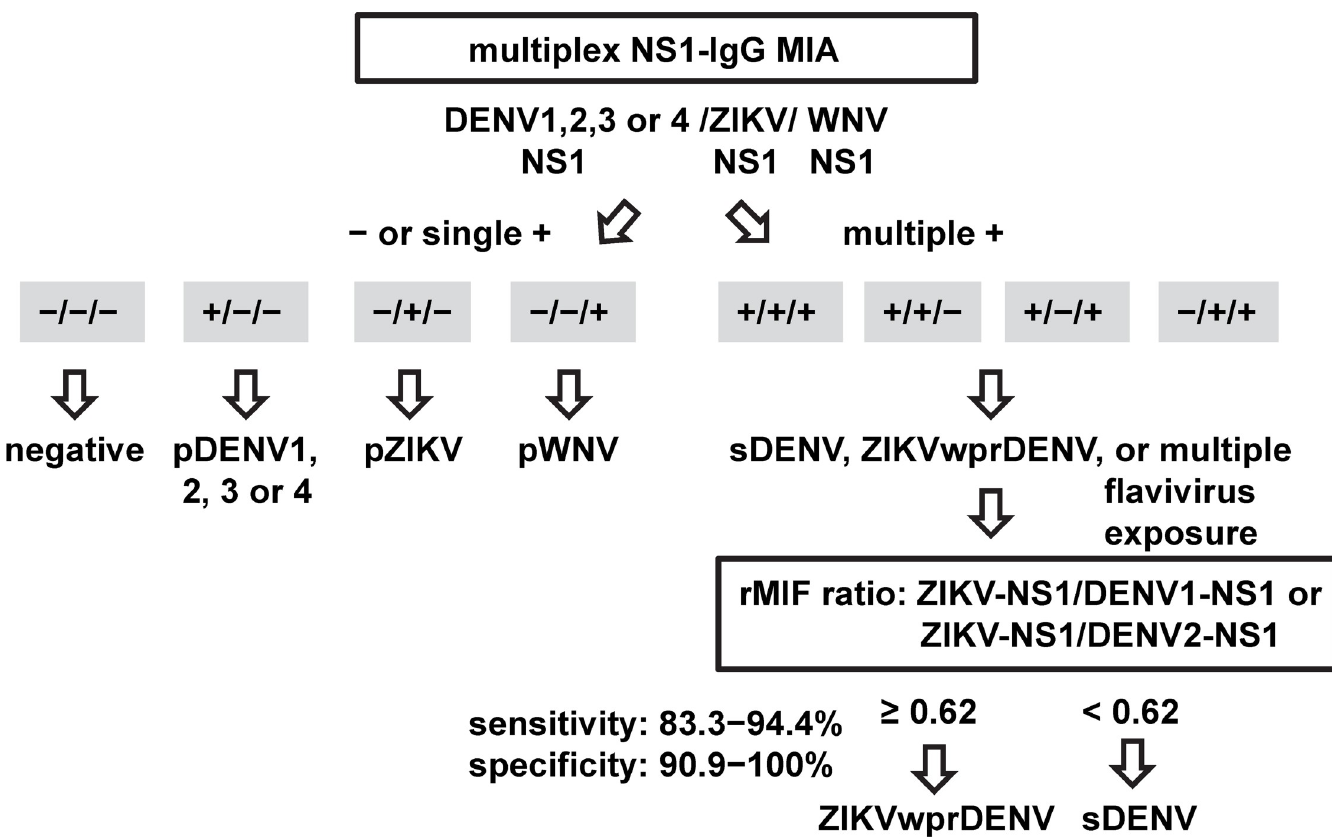
Fig 5. Proposed algorithm of using multiplex NS1 IgG MIA to distinguish three flavivirus infections. Based on positivity to NS1 proteins of three serocomplexes (DENV [DENV1, 2, 3 or 4], ZIKV and WNV NS1), the samples that were negative to all NS1 proteins or positive to NS1 protein of one serocomplex (DENV, ZIKV or WNV) could be flavivirus na ï ve or primary DENV, pZIKV or pWNV infection. For samples that were positive to NS1 proteins of two or more serocomplexes, the rMFI ratio of ZIKV NS1 to DENV1 or DENV2 NS1 was calculated to distinguish sDENV and ZIKVwprDENV